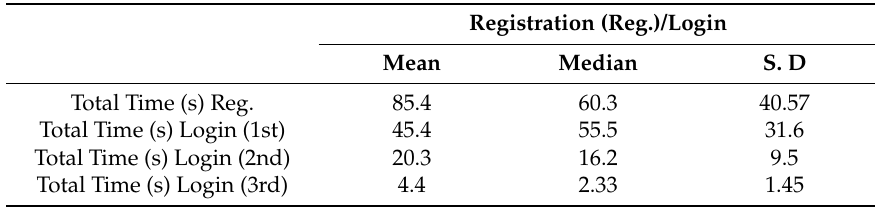
Table 5. Average time in seconds at login and registration